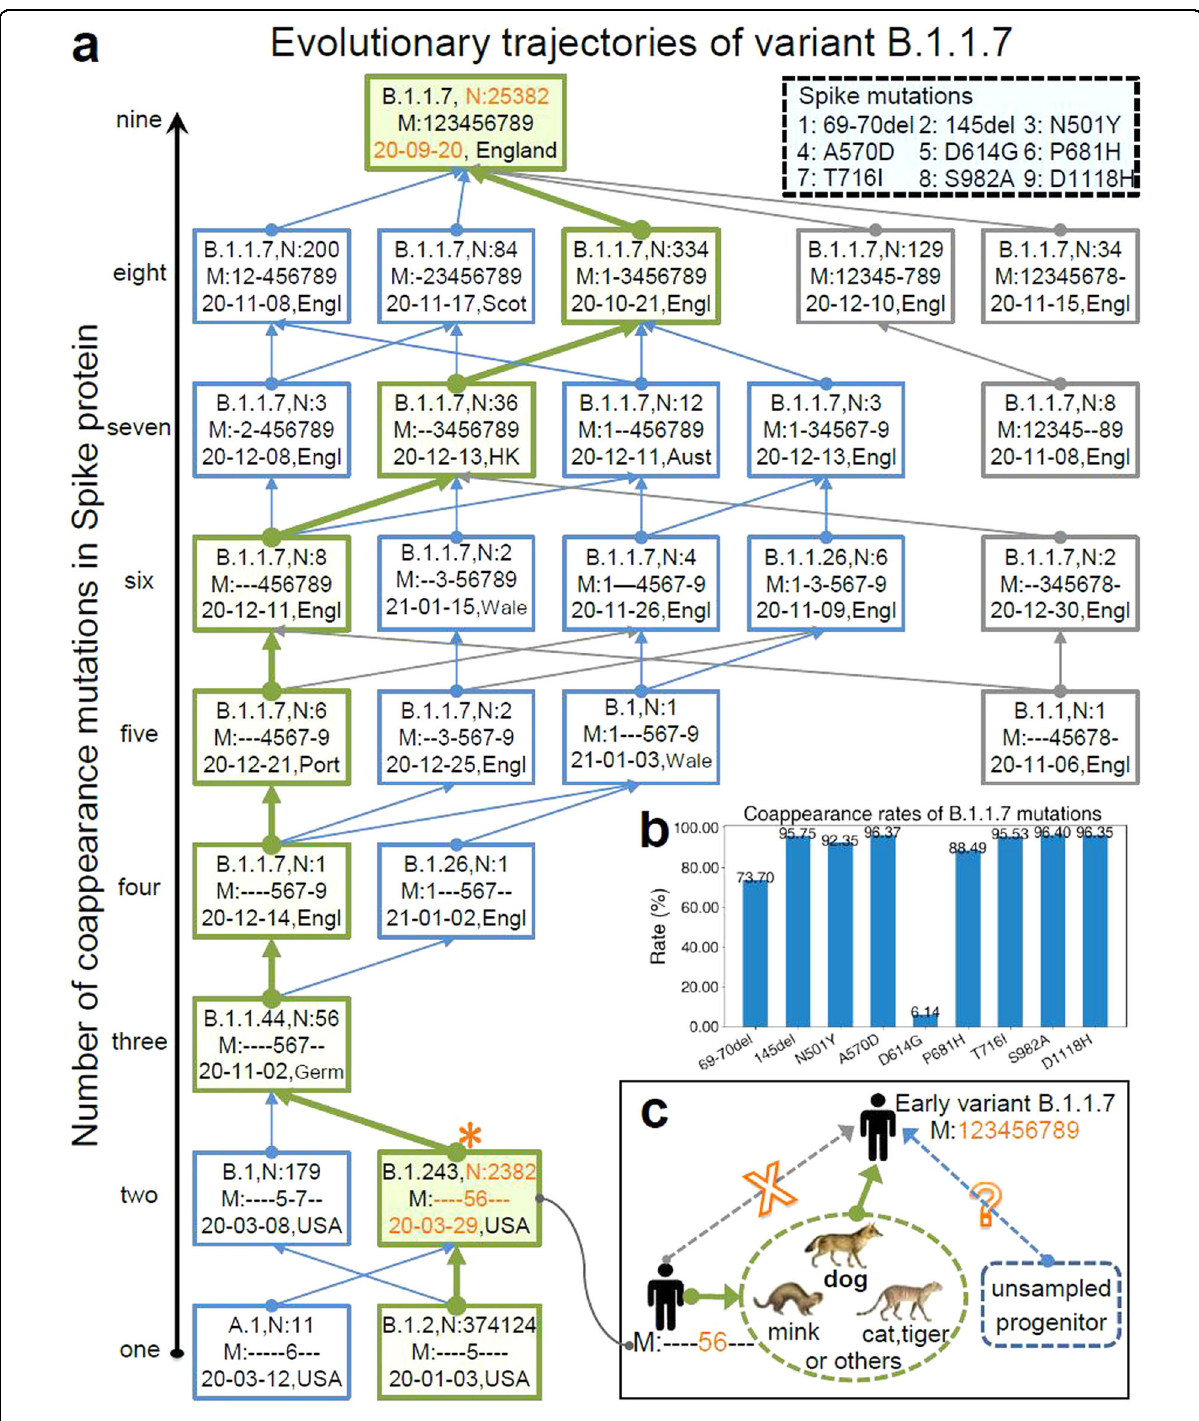
Fig. 1 Evolutionary trajectories of variant B.1.1.7. a Incremental mutations of variant B.1.1.7. The digits in the upper-right-corner rectangle with dotted line indicate the labels of mutations. For simplicity, the 69 – 70 deletions were labeled as “ 1 ” , and the other mutations “ 2 ”–“ 9 ” , respectively. The bottom nodes (rectangles) represent the variants with one mutation and the top one was the early variant B.1.1.7. Each rectangle with solid line consists of lineage (e.g., B.1.243), number of strains (e.g., N:2382), mutation sites (e.g., M:----56---), the earliest collection date (e.g., 20-03-29), and collection location (e.g., USA). In the labels of the mutation sites, sign “ - ” indicated the corresponding site did not mutate. All routes along the directions of the arrows are possible evolutionary trajectories of lineage B.1.1.7, where the green one was the most probable mutation trajectory. Large-scale SARS-CoV-2 analysis demonstrates that the early variant B.1.1.7 might not have arisen spontaneously in the United Kingdom or within human hosts. b Co-appearances of variant B.1.1.7 mutations. At least fi ve mutations form a potential co-mutation pattern (coappearance rate >95%). c Possible transmission chains of variant B.1.1.7. Canidae, Mustelidae or Felidae, especially the Canidae family (e.g., dog) could be a possible host of the direct progenitor of variant